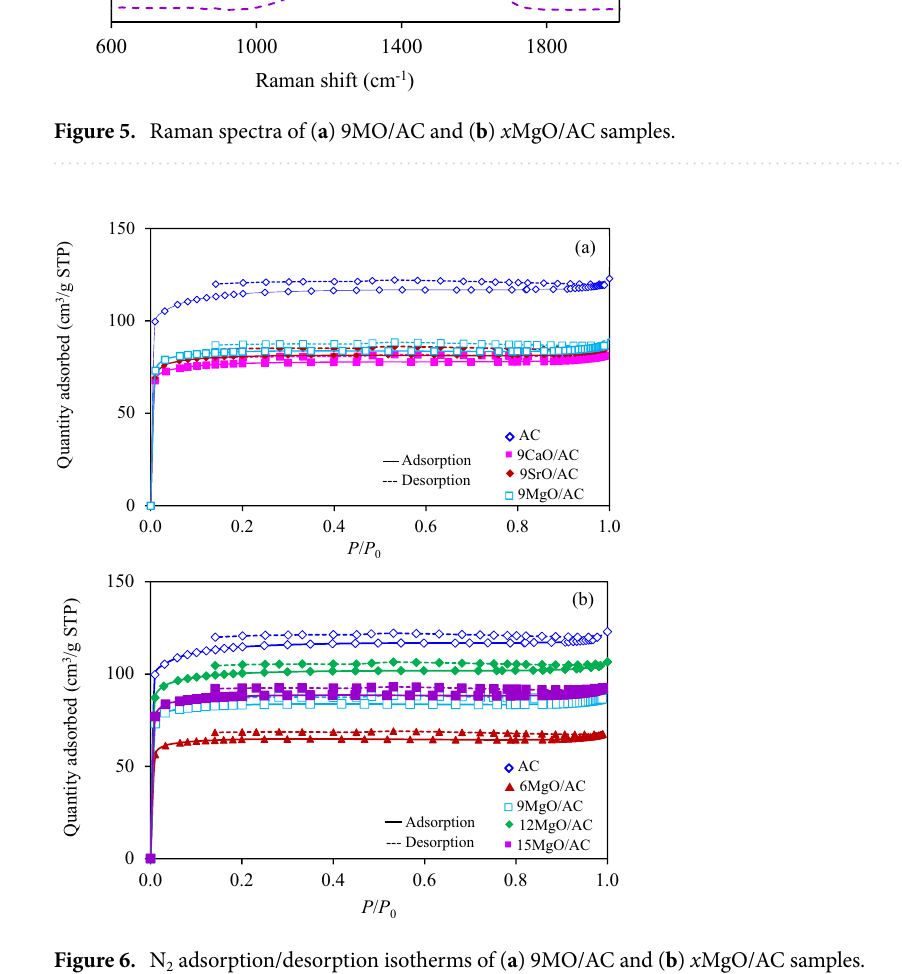
Figure 6. N 2 adsorption/desorption isotherms of ( a ) 9MO/AC and ( b ) x MgO/AC